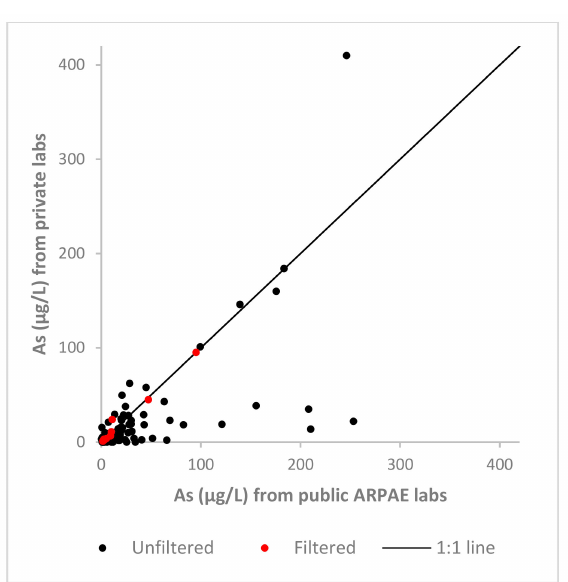
Figure 2. Scatter plot of filtered vs unfiltered As concentrations from the same samples. The counter-analyzed As concentrations (Figure 3) show good alignment on the 1:1 line between the public and private labs in the case of filtered samples, even if very few data were available for the comparison (11 samples). On the contrary, the unfiltered data, available in a larger number (115 samples), indicate a much larger variability. In most cases, the unfiltered concentration from the private labs is lower than that of the public lab. This highlights the poor reliability of the unfiltered data.